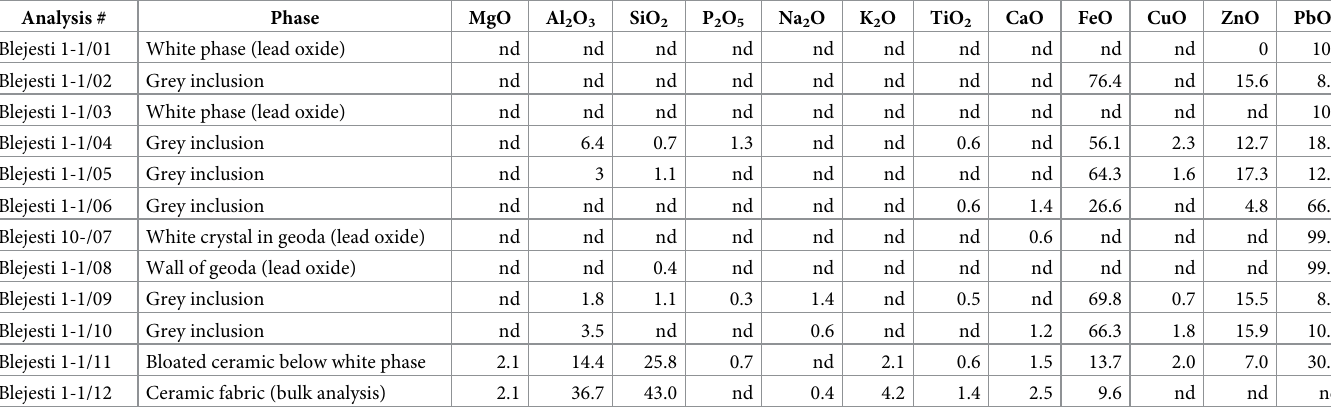
Table 3. Phase composition of the glassy layer on the inner surface of the vessel Bleje ş ti 1–1. Analysis